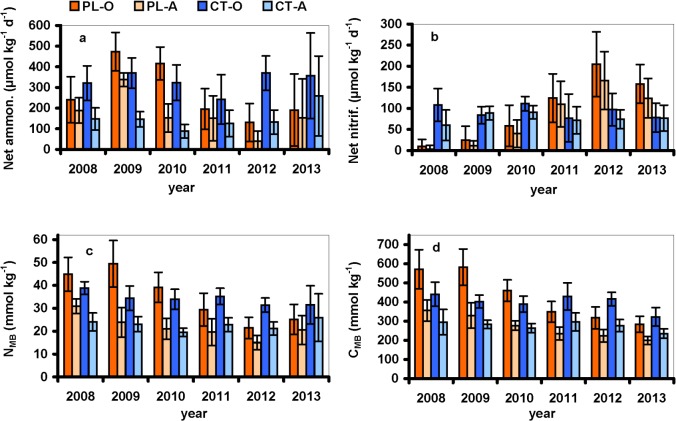
Annual average (n = 8–9 for each year) rates of (a) net ammonification and (b) net nitrification rates, and concentrations of (c) nitrogen (NMB) and (d) carbon (CMB) in soil microbial biomass in the O and A soil horizons at the Plešné (PL) and Čertovo (CT) plots.Vertical bars denote 95% confidence intervals.